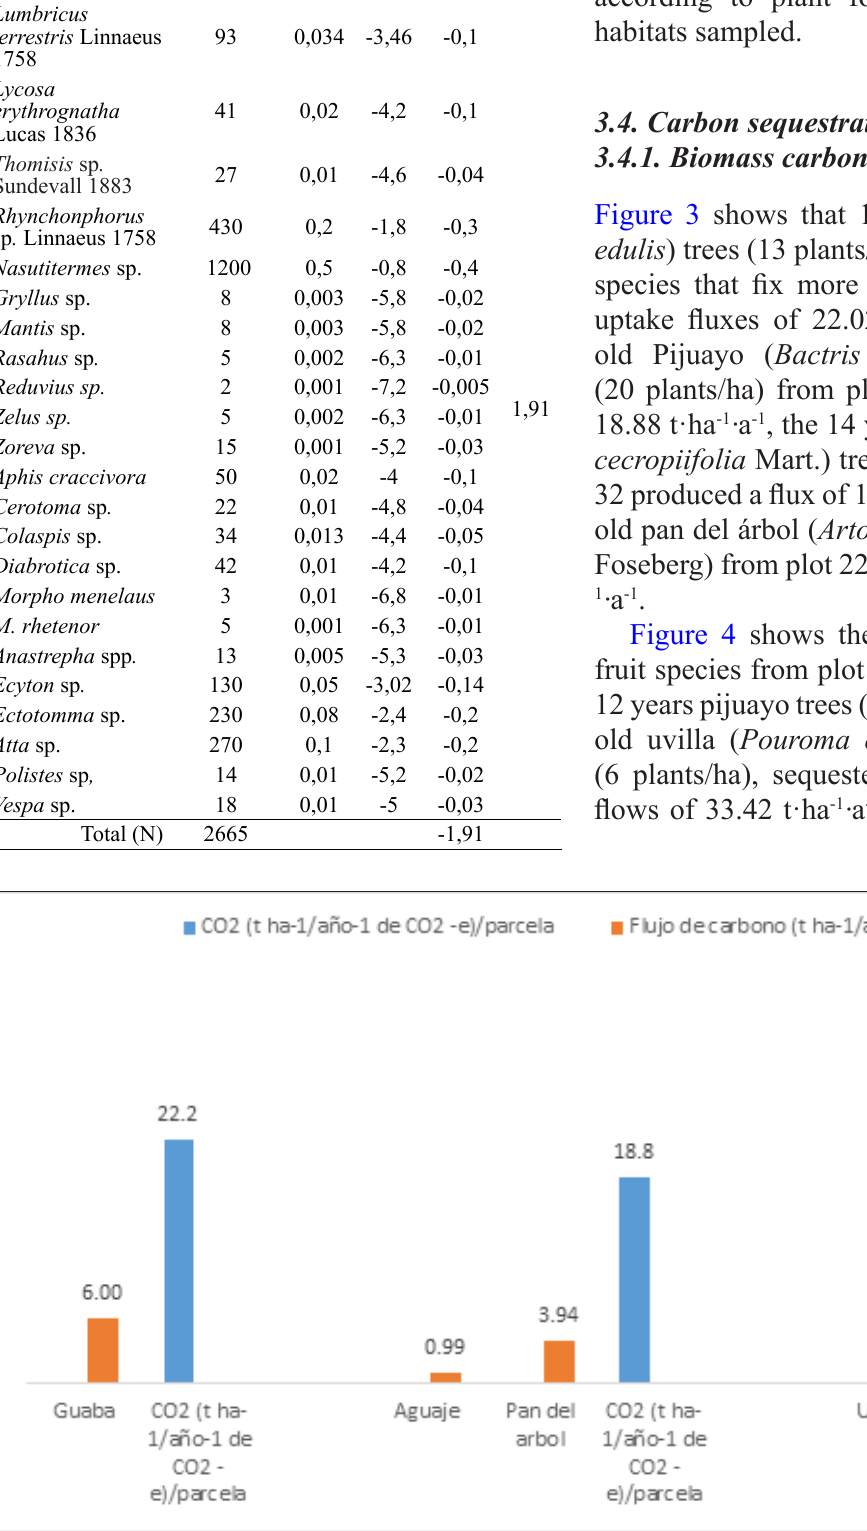
Figure 3: Carbon sequestration in biomass in Amazonian fruit trees in producing plots of Amazonian fruit trees in Iquitos - Nauta road,